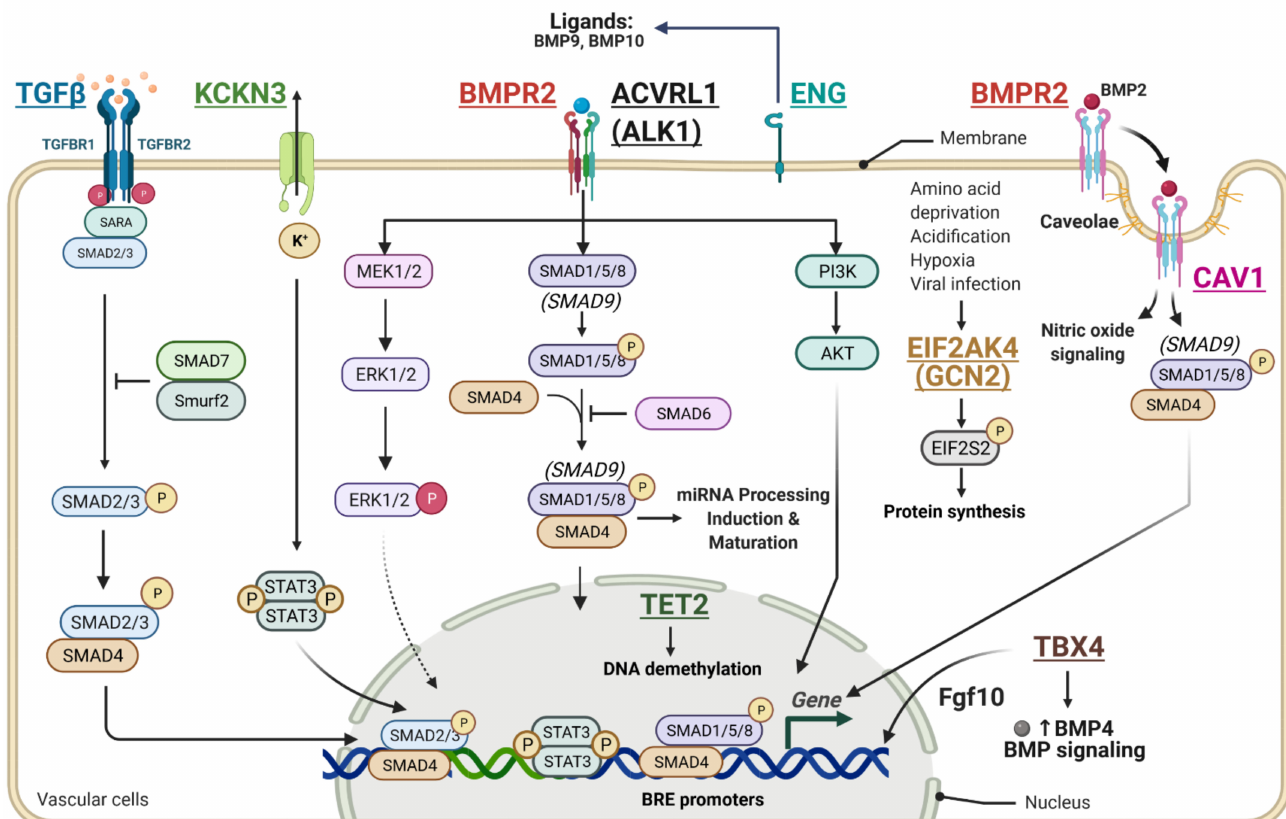
Figure 1. Gene variants in HPAH impairs the BMP signaling and potentiates the development of PAH. Heritable pulmonary hypertension (HPAH) is associated with various genetic mutations (i.e., BMPR2, ENG, ALK1, SMAD9, E1F2AK4, CAV-1, KCNK3, and TBX4). Genetic variants are characterized by a loss-of-function in PAH and converge within the BMP-Smad 1/5/8 signaling, increasing the proliferation, apoptosis resistance, migration in vascular cells, and the development of PAH. Dysregulation of the BMPR2 signaling impairs the MAPK and PI3K/AKT signaling. Mutations in the KCNK3 gene induce membrane depolarization and opening of voltage-gated calcium channels, which increase the free cytosolic calcium concentration in PASMCs and promote vasoconstriction as well as vascular remodeling. The loss of Cav-1 induces the disruption of caveolae, blocks the initiation of the SMAD signaling, increases endothelial nitric oxide synthase (eNOS) activity, and potentiates the development of PAH through protein kinase G (PKG) nitration. TBX4 plays a central role in the development of the respiratory tract and lung branching during embryogenesis through its interaction with fibroblast Growth Factor 10 (Fgf10). ACVRL1, activin receptor-like 1 (ALK1); Bone morphogenetic protein receptor type 2 (BMPR2); Caveolin-1 (Cav-1); Endoglin (ENG), Eukaryotic Translation Initiation Factor 2 Alpha Kinase 4 (EIF2AK4); SMAD, mothers against decapentaplegic homolog 9 (SMAD9), Signal Transducer And Activator Of Transcription 3 (STAT3); T-Box Transcription Factor 4